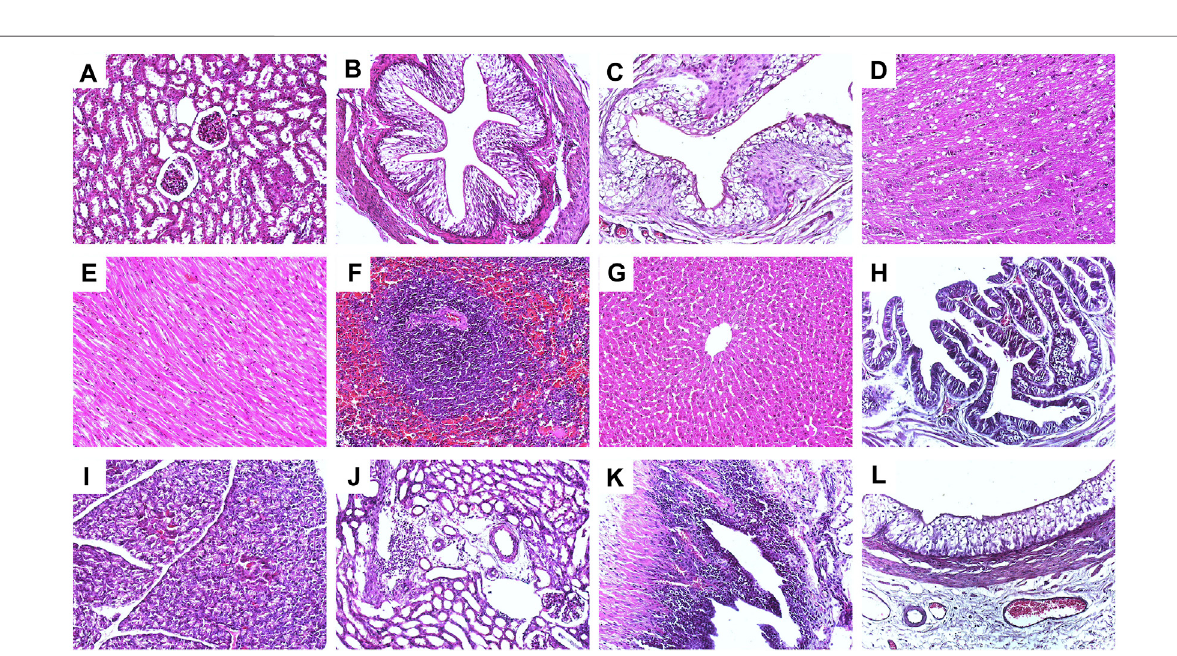
Frontiers in Bioengineering and Biotechnology |